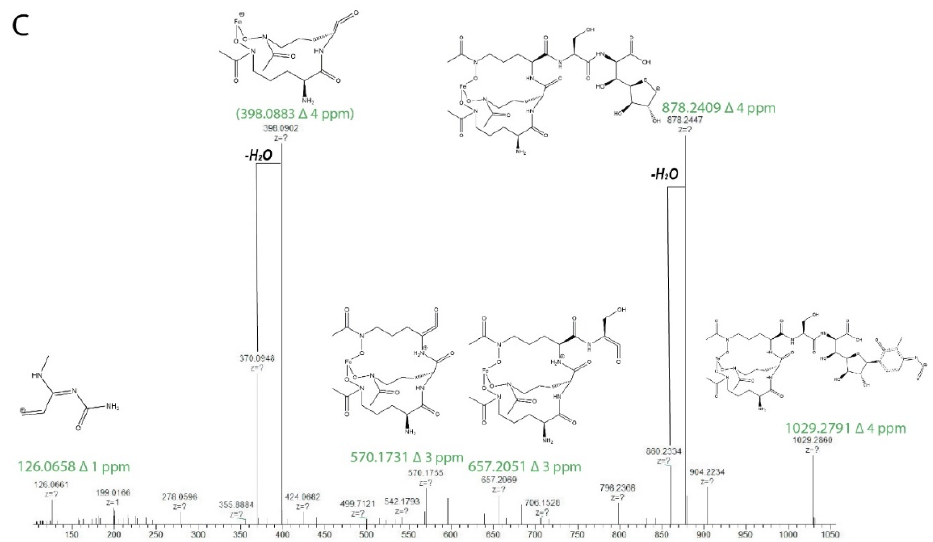
Figure 6. Identification of albomycin δ 2. ( A ) Molecular structure of albomycin δ 2. ( B ) Albomycin δ 2 molecular ion [M + H] + observed at 1046.3102 and its isotopic distribution (calculated mass are signed as red). ( C ) The positive-mode HCD mass spectra of the parent ion at m / z 1046.3102 with the molecular fragment structures (calculated mass for the fragments are signed as green).